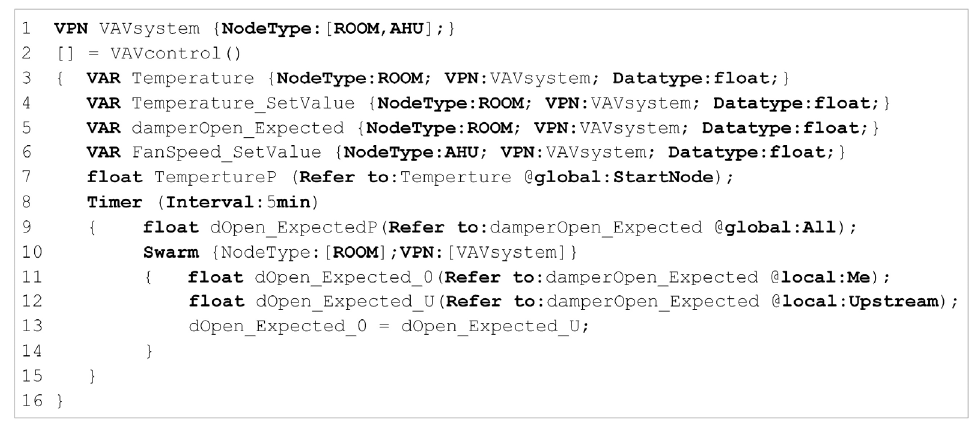
Figure 6. Example of a SwarmL